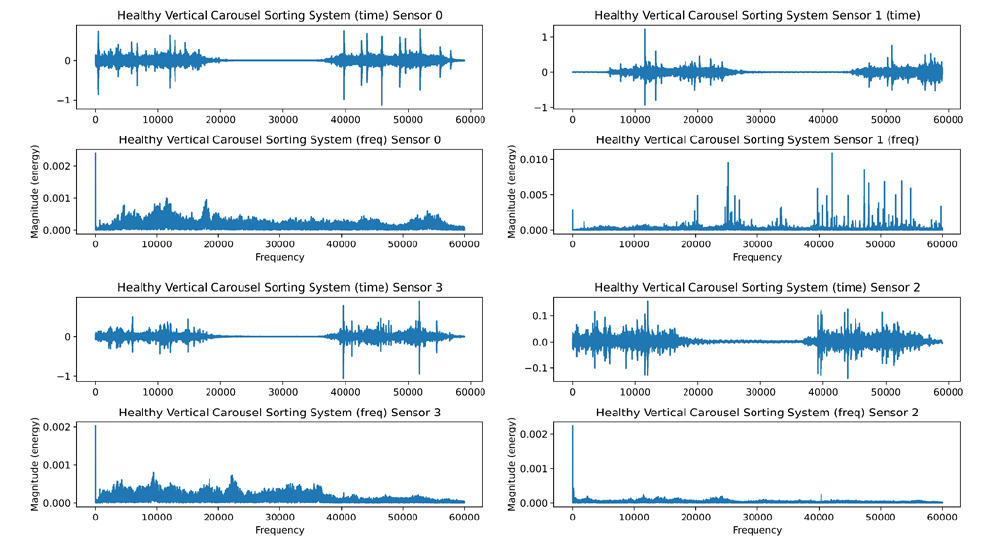
Figure 7. The healthy time and frequency analysis for the VCSRS vibration